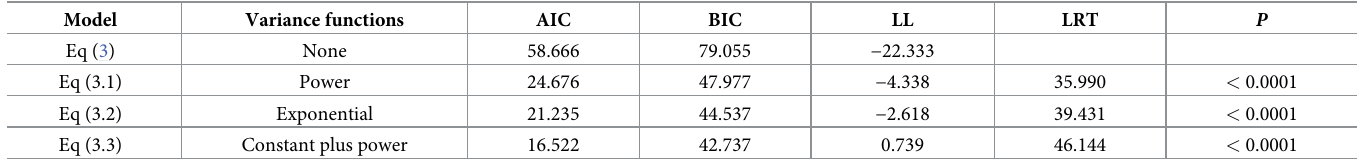
Table 5. Mixed-effects model performance with different variance functions.